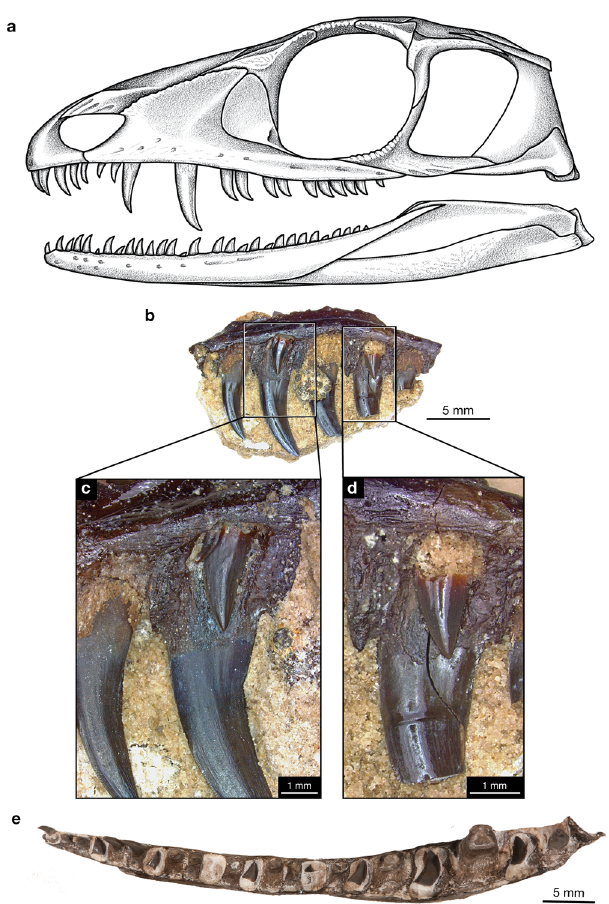
Fig. 1 | Tooth replacement in maxillary dentition of Mesenosaurus efremovi . a Reconstruction of M. efremovi skull in lateral view. Note that gaps in dentition representshedteeththatarebeingreplaced. b MaxillarydentitionofROMVP85456 in lingual view. c Tooth family with a functional tooth and two successive repla- cement teeth. d Tooth family with a functional tooth and a single replacement tooth. e Photographofmaxilla(ROMVP85524)inocclusalviewshowingthepattern of tooth replacement, with new teeth developing in the sockets of old teeth after the latter were